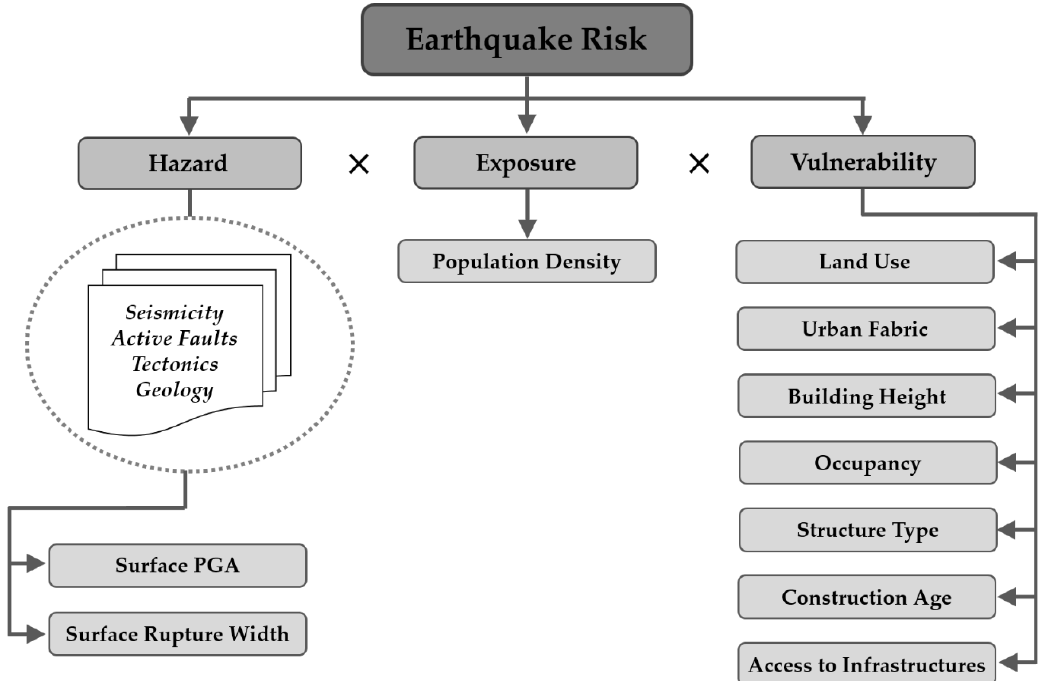
Figure 2. Flowchart representing the process of earthquake risk assessment as applied to